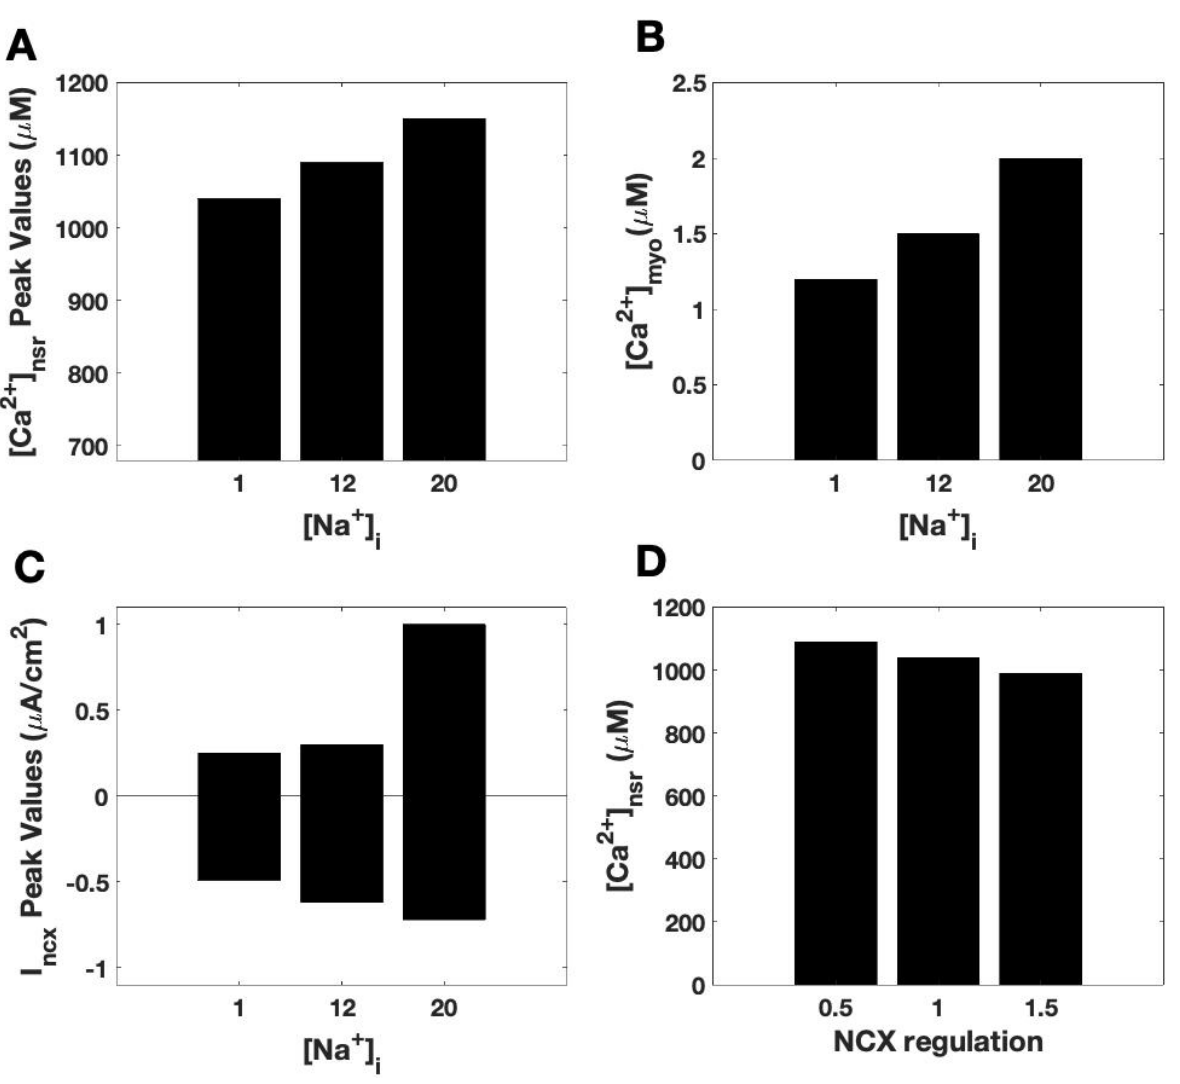
Figure 11. Tables for analyzing the dependence of Calcium dynamics on [Na + ] i and Na + /Ca 2+ exchanger activity (NCX). ( A ) Peak network SR Ca2 concentration ([Ca 2+ ] nsr ) at different myoplasmic Na + concentrations ([Na + ] i ). ( B ) Peak myoplasmic Ca 2+ concentration ([Ca 2+ ] myo ) at different values of [Na + ] i and ( C ) Peak forward and reverse Na + /Ca 2+ exchanger (NCX) current at different values of [Na + ] i . ( D ) Peak [Ca 2+ ] NSR at different Na + /Ca 2+ exchanger (NCX) activity levels.